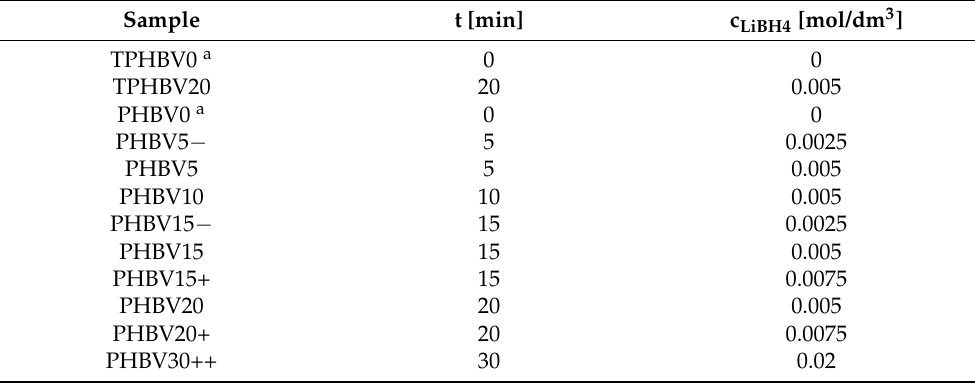
Table 1. Denotation of the LiBH 4 -treated PHBV